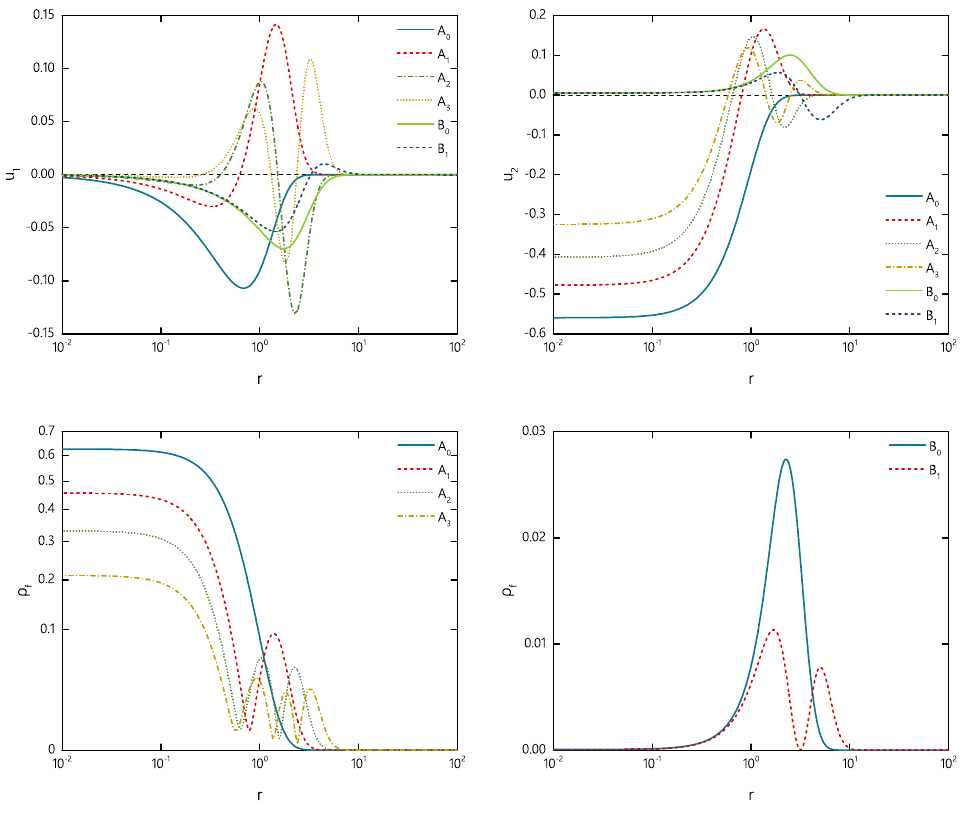
Figure 2 . Fermionic field profile functions v 1 = u 2 (upper left) and v 2 = the fermionic densities for A k modes ρ A (lower left) and for B k modes ρ B (lower right) are plotted as functions of the radial coordinate r at g = 1, m = 0 and κ 0 = 0 .